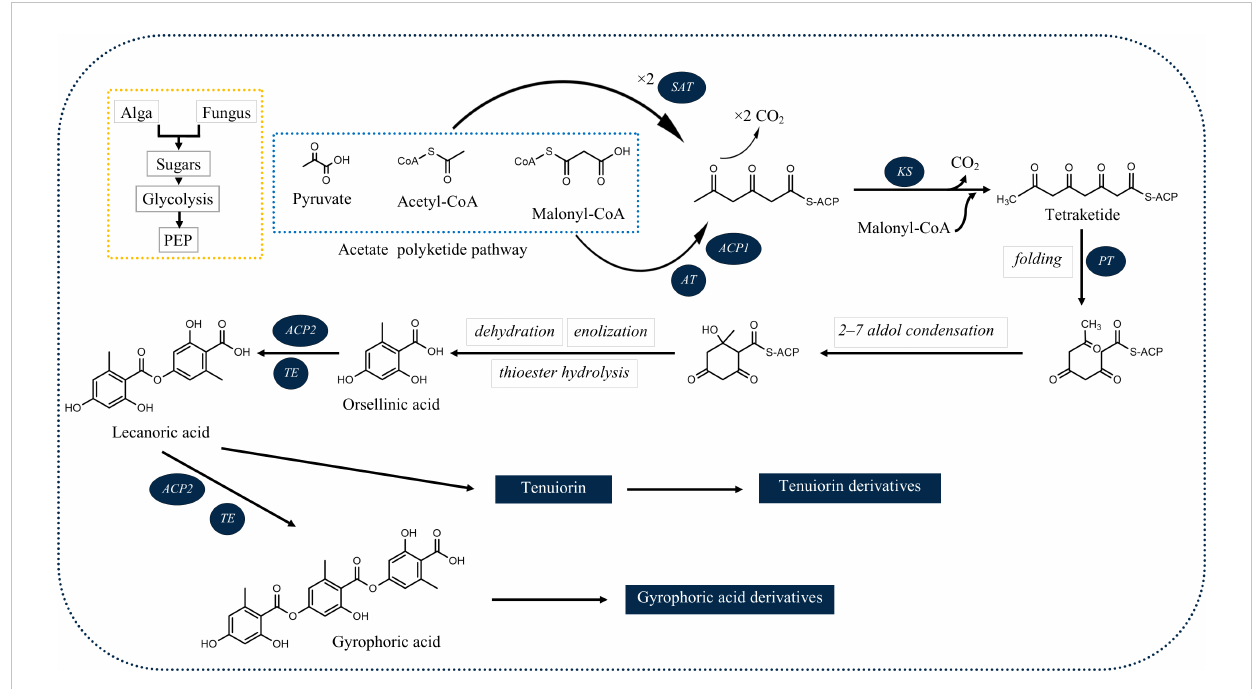
FIGURE 1 Deduced biosynthetic pathway of some of the common lichenic tridepsides. SAT, starter acetyltransferase; KS, ketosynthase; AT, acyltransferase; PT, product template domain; ACP1, acyl carrier protein 1, ACP2: acyl carrier protein 2; TE,